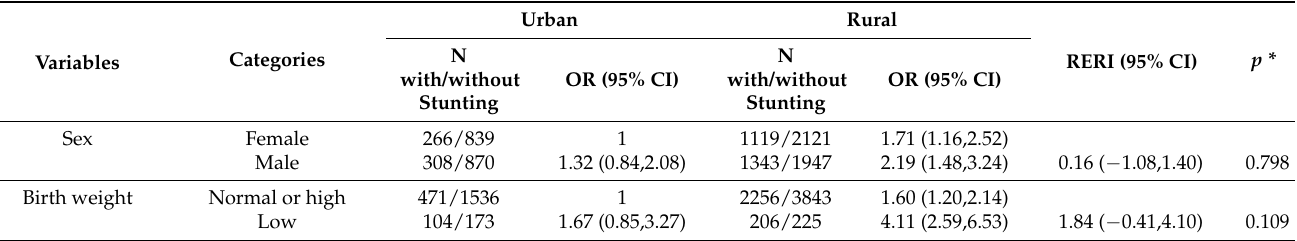
Table 4. The interaction effects between residence and other individual-level and household-level covariates based on 2015–2016 Tanzania Demographic and Health